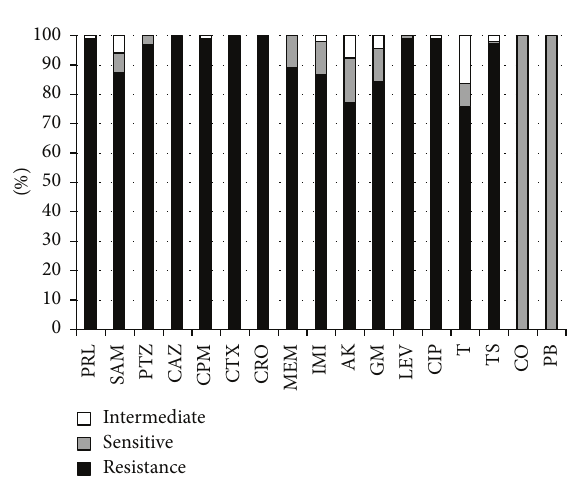
Figure 1: Antimicrobial susceptibility test of 124 A. baumannii isolates in Iran. PRL: piperacillin; SAM: ampicillin-sulbactam; PTZ: piperacillin-tazobactam; CAZ: ceftazidime; CPM: cefepime; CTX: cefotaxime; CRO: ceftriaxone; MEM: meropenem; IMI: imipenem; AK: amikacin; GM: gentamicin; LEV: levofloxacin;